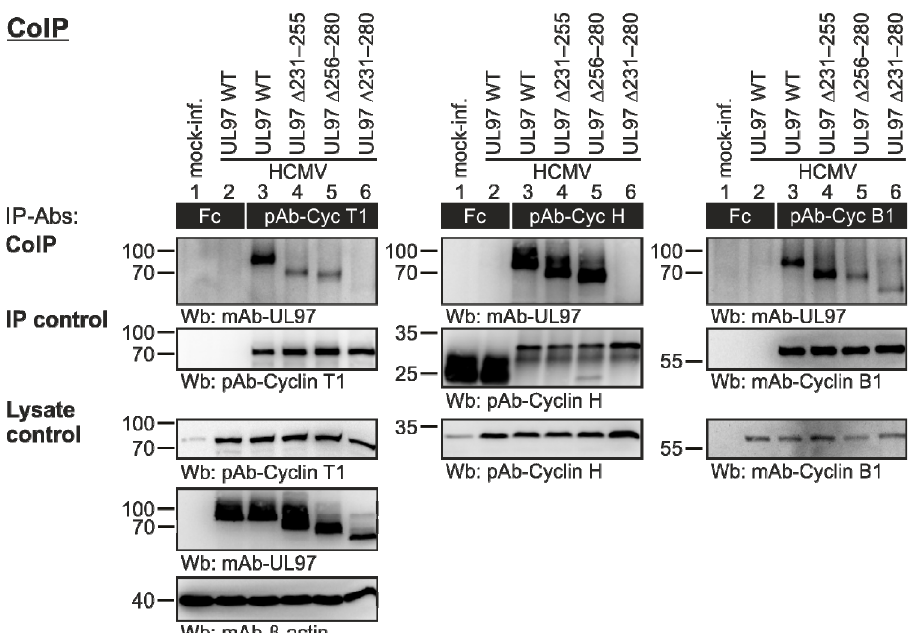
Figure 3. Interaction analysis of pUL97 with human cyclins. HFFs were infected with HCMV WT or UL97 mutant versions at an MOI of 1. At 4 d.p.i. (WT) or the time point referring to approximately 80% of virus-induced CPE (mutants), cells were lysed and human cyclins T1, H and B1 were immunoprecipitated using specific Abs; a rabbit Fc fragment served as specificity control. Subsequently, CoIP sample and lysate control taken prior to the addition of IP-Abs were subjected to standard Wb analysis using specific Abs as indicated. Note that pUL97 ∆ 231–280 no longer interacted with cyclin T1 and H, whereas all mutants retained the interaction with cyclin B1.